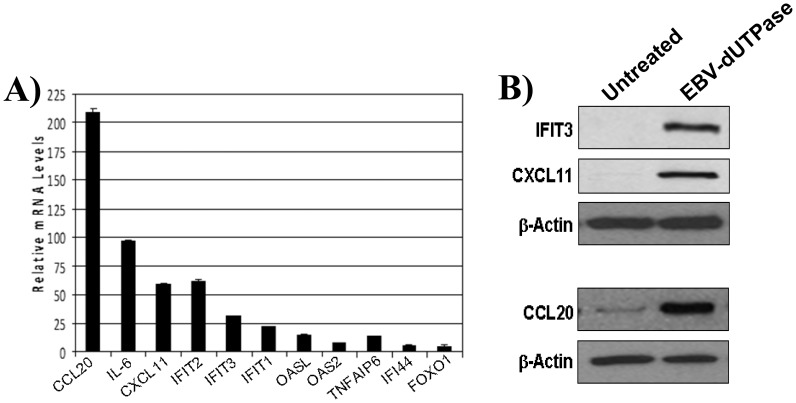
Validation of select target genes up-regulated in microarray studies.
A) RNA from untreated or EBV-encoded dUTPase treated hDCs for 4 h was examined by qRT-PCR for the expression of CCL20, IL-6, CXCL11, IFIT1, IFIT2, IFIT3, OASL, OAS2, TNFAIP6, IFI44 and FOXO1 using specific TaqMan gene expression assays (ABI). Samples were normalized to GAPDH and expressed as the mRNA expression levels relative to untreated control. B) Western blot analysis of CCL20, CXCL11 and IFIT3 using whole cell lysates from untreated or EBV-encoded dUTPase-treated and protein specific Abs (1∶200 dilution).